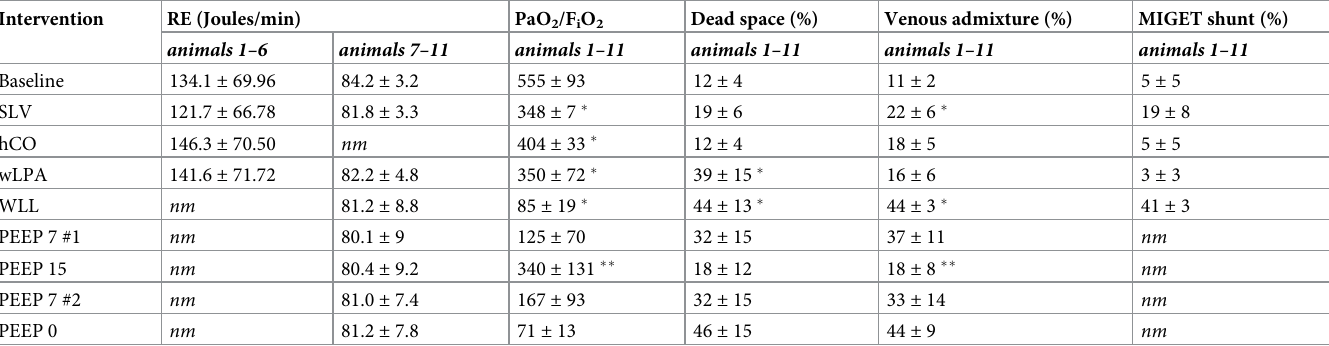
Table 3. Results for RE, PaO 2 /F i O 2 ratio, dead space and venous admixture.